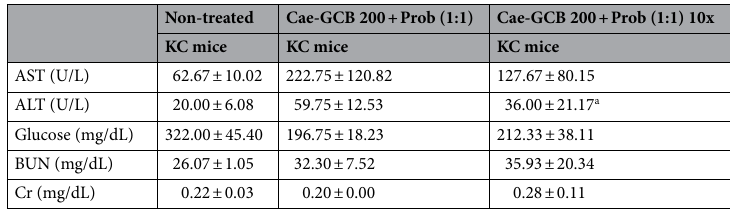
Table 2. Comparison of biochemical values in KC transgenic mice after treatment with caerulein (Cae) and gemcitabine (GCB) with different doses of probiotics. ALT, alanine aminotransferase; AST, aspartate aminotransferase; BUN, blood urea nitrogen; Cae-GCB 200 + Prob (1:1), caerulein(25 μg/kg) + gemcitabine (200 mg/kg) + probiotics(GMNL133: GMNL89 = 1:1); Cae-GCB 200 + Prob (1:1) 10x, caerulein (25